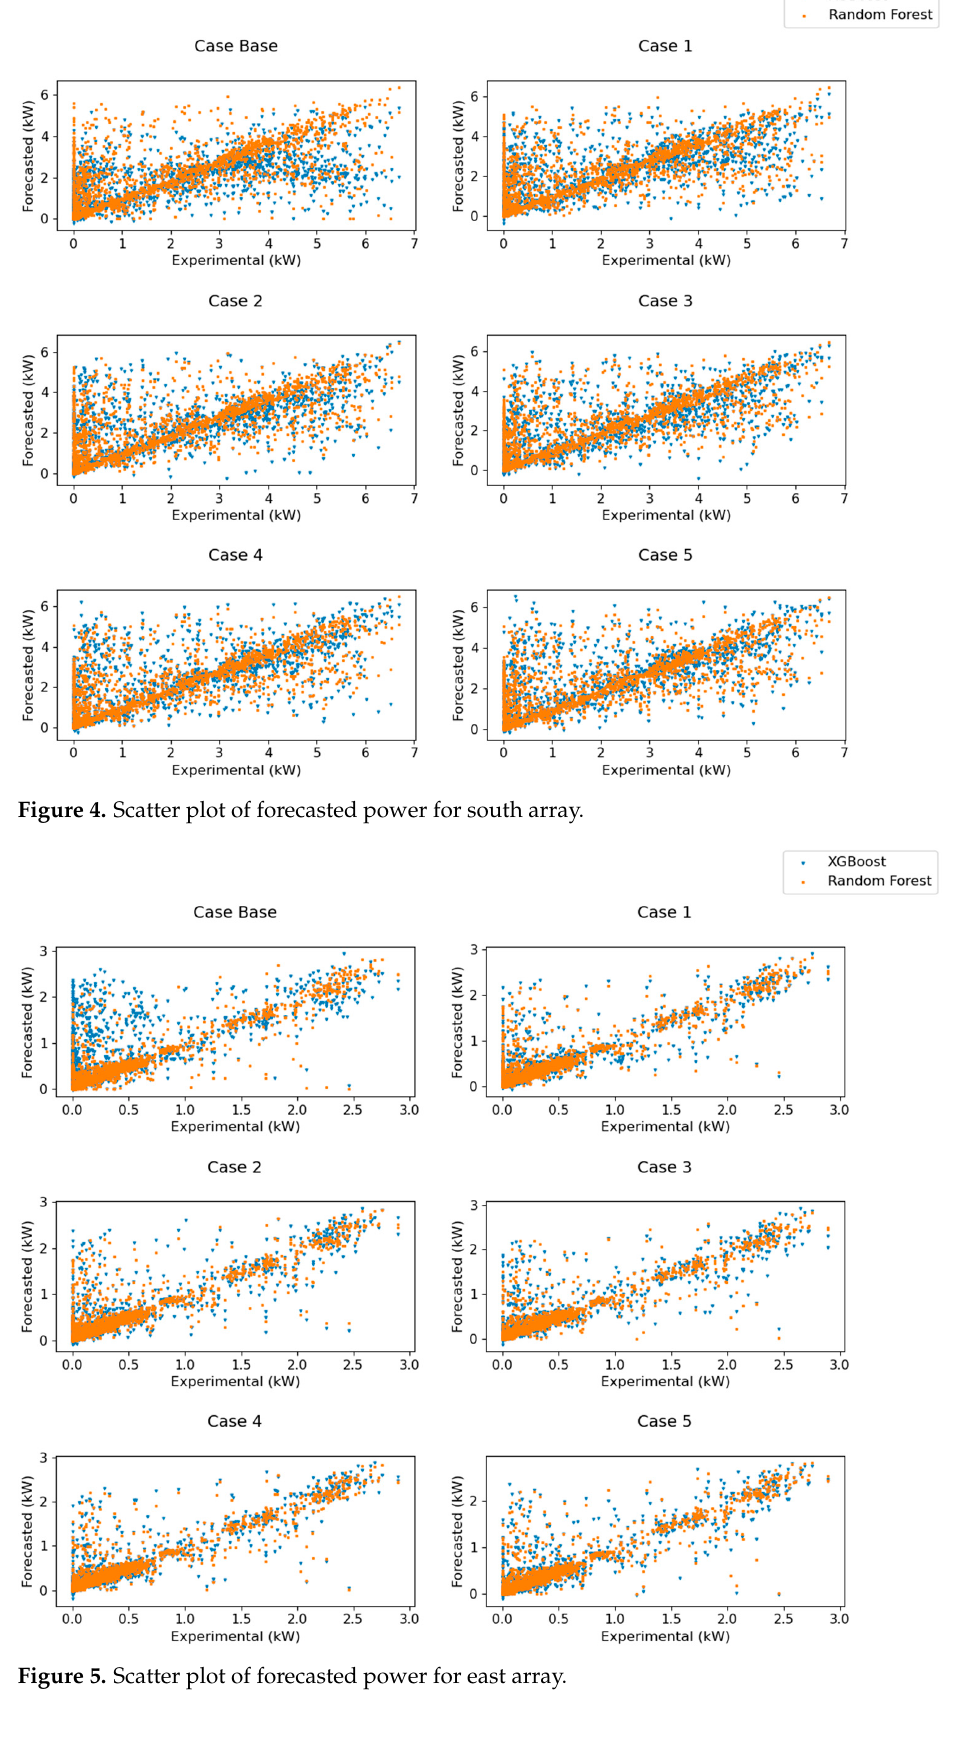
Figure 5. Scatter plot of forecasted power for east Figure 5. Sca tt er plot of forecasted power for east array. Figure 5. Sca tt er plot of forecasted power for east array.